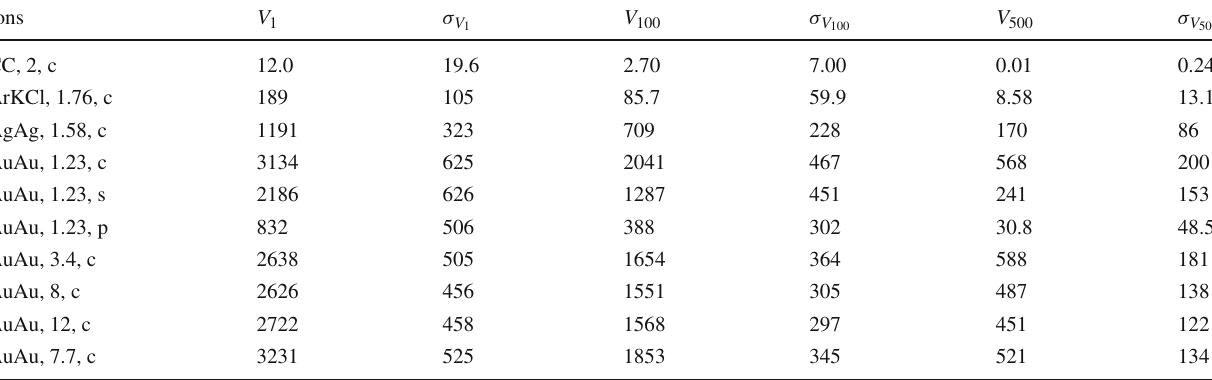
Table 9 Results for X ebe < 0 . 5 and Y ebe < 0 .